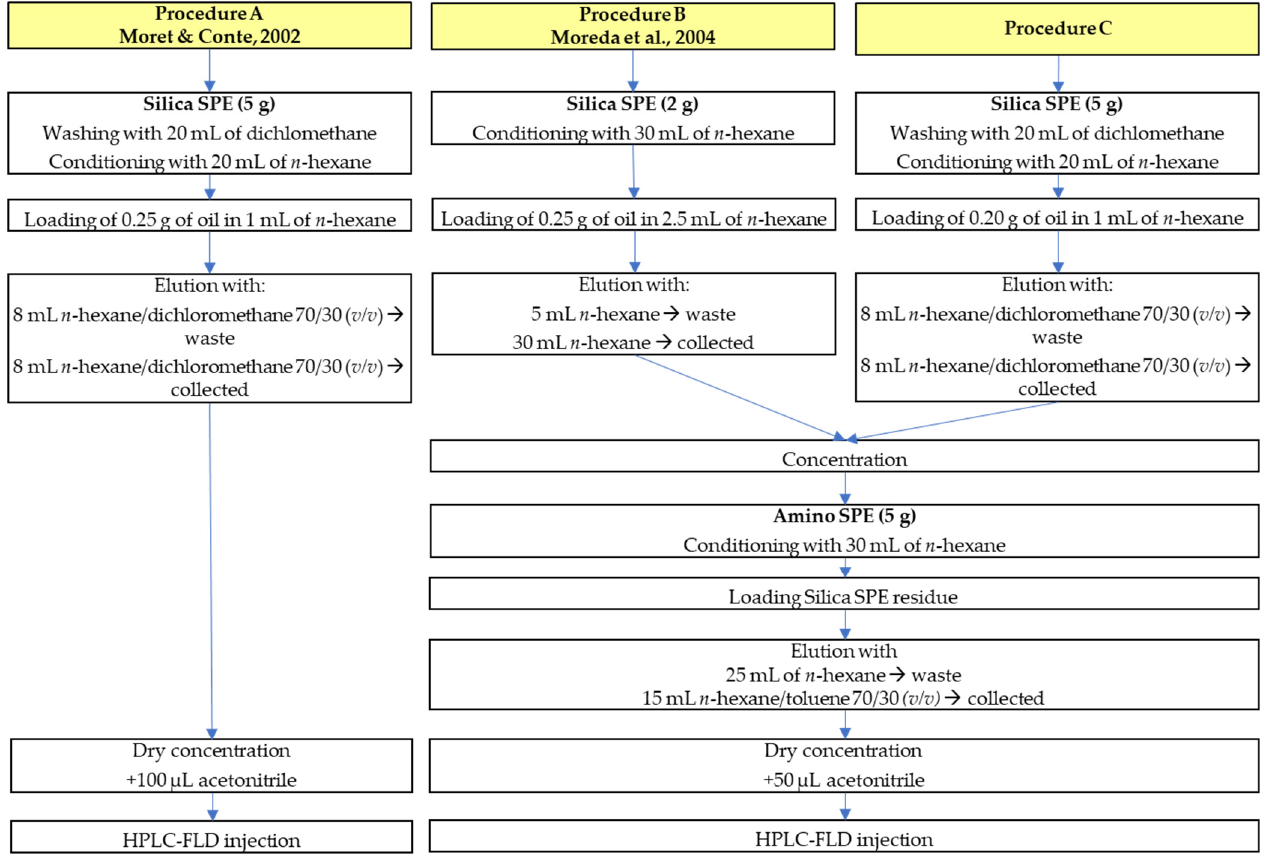
Figure 1. Flow chart of SPE protocol comparison for olive pomace oil purification. Moret & Conte, 2002 [34]; Moreda et al., 2004 [35].